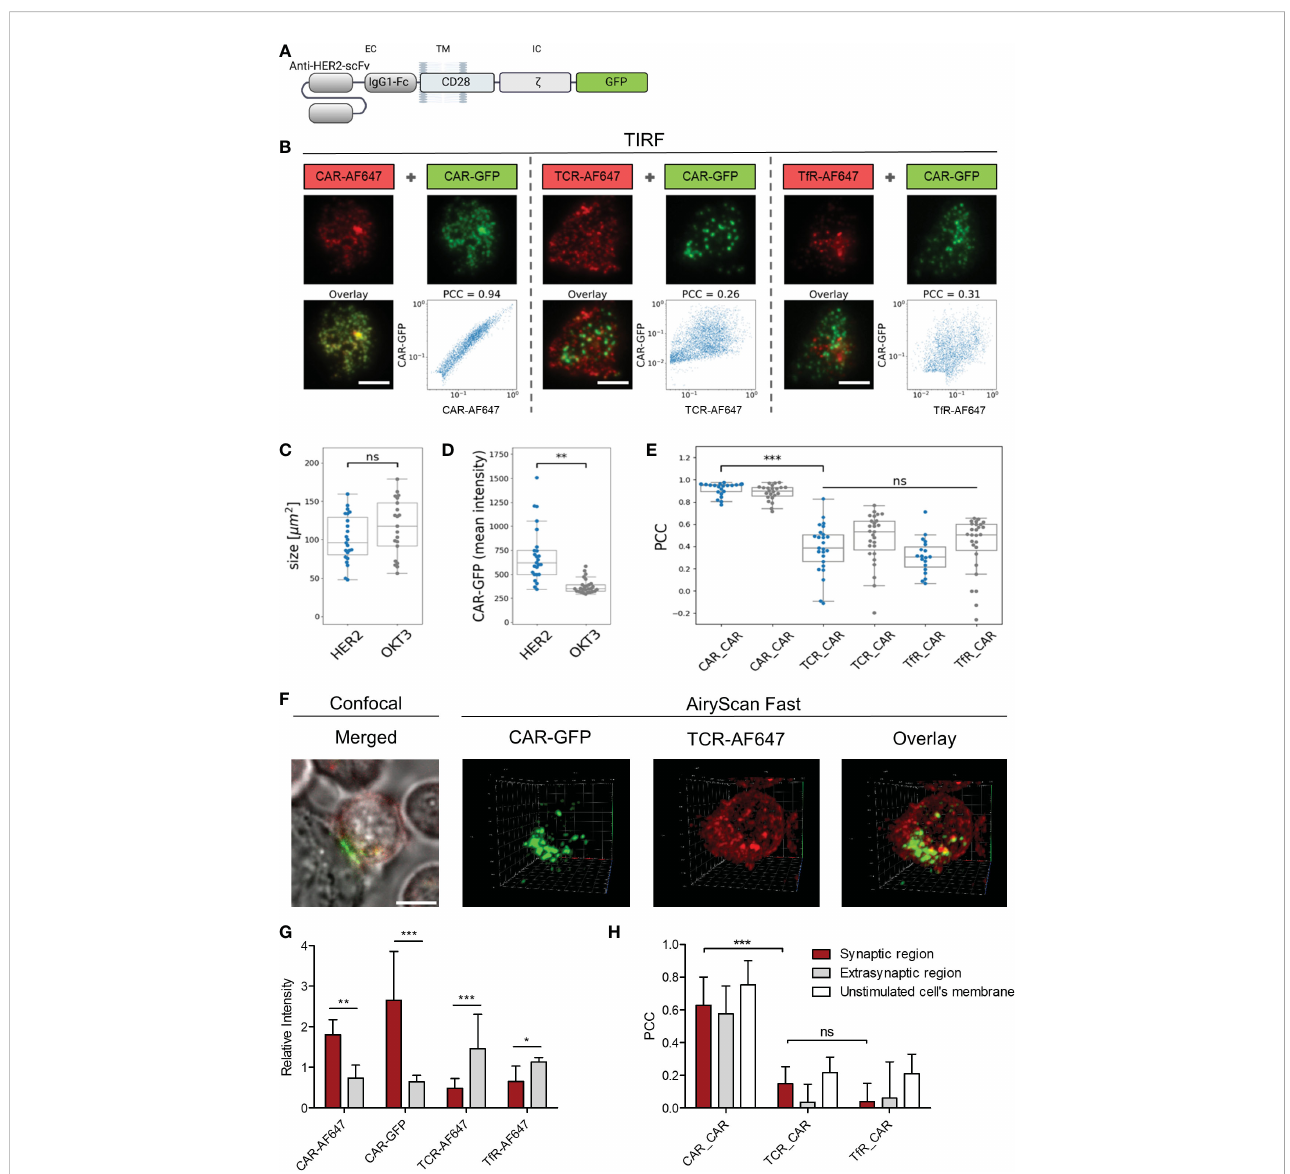
FIGURE 4 z CAR engagement of antigen induced clustering without TCR integration. Anti − HER2 CAR T cells were labeled with either AF647 − conjugated F(ab´) 2 goat anti − human IgG antibody that recognizes the CAR, anti − TCR a / b AF647-conjugated antibody, or AF647-conjugated anti − transferrin receptor (TfR) antibody. (A) Schematic representation of the used anti − HER2 CD28 z CAR linked to GFP at the intracellular site (IC). (B) Cells were seeded onto surfaces coated with HER2 protein or anti − CD3 antibody OKT3 and contacts were formed for 20 minutes. Cells were fi xed and TIRF microscopy was used to image the localization of CAR-GFP (green) and either CAR-AF647, TCR-AF647, or TfR-AF647 (red). Scale bar represents 5 µm. For each cell, the pixel- wise correlation of the brightness values recorded in the red and in the green channel were plotted along the x- and the y-axis, respectively. Pearson ’ s correlation coef fi cient (PCC) for each cell was calculated. Contact size (C) and Mean intensity (D) of anti − HER2 CAR-GFP plated on HER2 (blue) and OKT3 coated slides (grey) are displayed for n ≥ 16 cells per group in a Whisker box plot. Statistical differences were determined by Wilcoxon-Mann- Whitney test with Python code (**p<0.01). (E) PCC for CAR-GFP and TCR-AF647 was calculated for anti − HER2 CAR T cells plated on HER2 (blue) and OKT3 (grey) coated slides and displayed for n ≥ 24 cells per group in a Whisker box plot. Statistical differences were determined by Kruskal-Wallis test with Dunn ’ s post-hoc test performed with Python code (***p<0.001). (F) Labelled anti-HER2 CAR T cells were seeded on HER2 expressing N87 target cells plated on chambered coverslips. 3D fl uorescence images of live anti-HER2 CAR T cells forming contacts with the tumor target were recorded